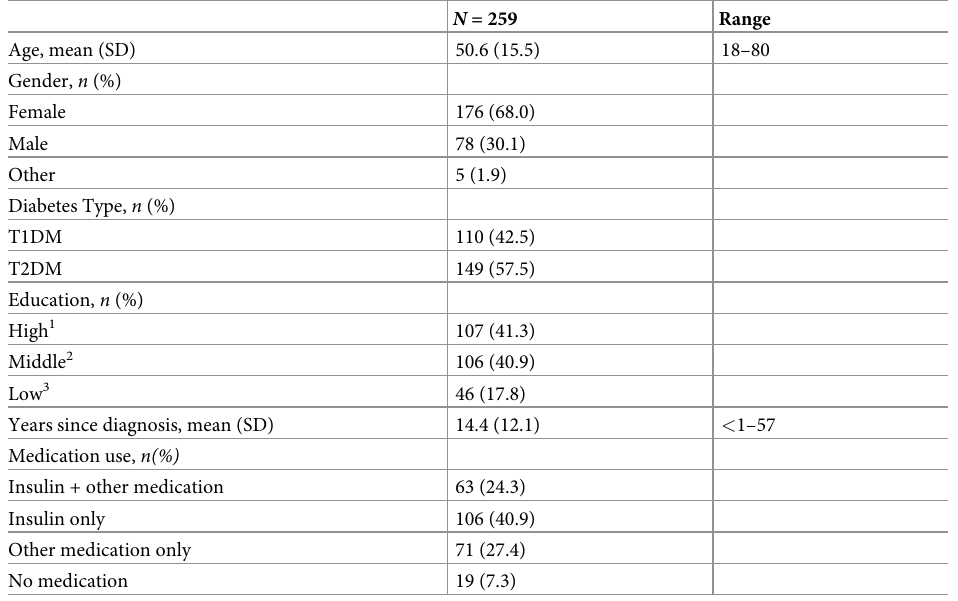
Table 2. Characteristics of the